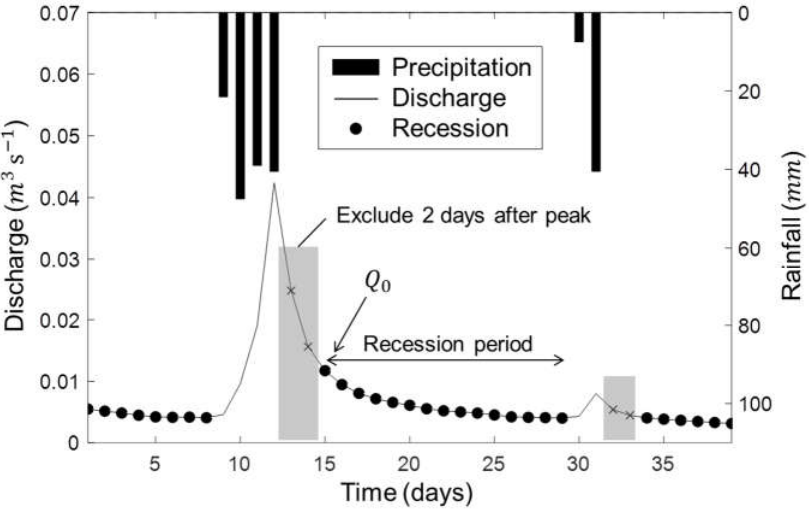
Figure 2. Determination of the recession periods from the Gwangneung deciduous (GD) catchment rainfall-runoff data. Two days after peak flow were excluded and recessions were chosen as being over eight days in length. The hydrograph was performed for periods at least eight consecutive days from the point at which two days passed after the peak flow until just before the next rainfall event was extracted. Q 0 is the initial discharge and is generally the starting point of the recession discharge.